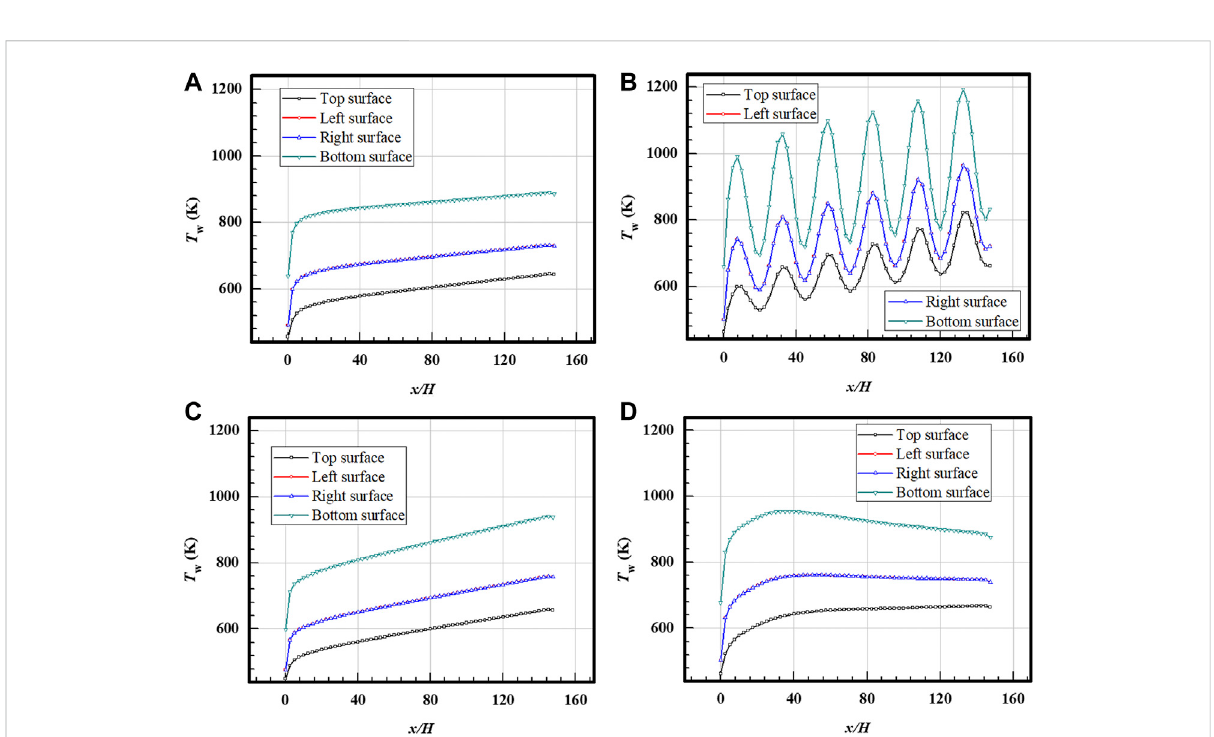
FIGURE 6 Temperature distributions along thestreamwisedirectionon channel wallsloaded with differentheat fl uxdistributions. (A) Case A; (B) CaseB3; (C) Case C2; (D) Case